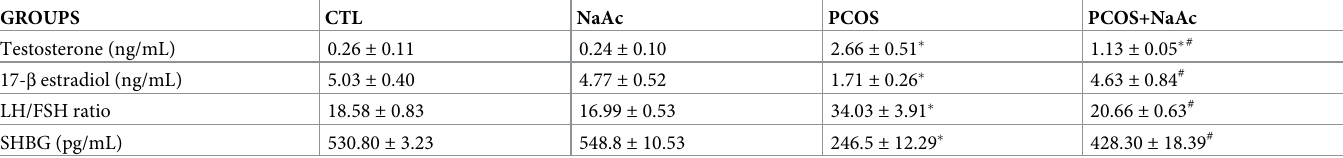
Table 1. Impact of sodium acetate on endocrine profile in LET-induced PCOS rat model. GROUPS